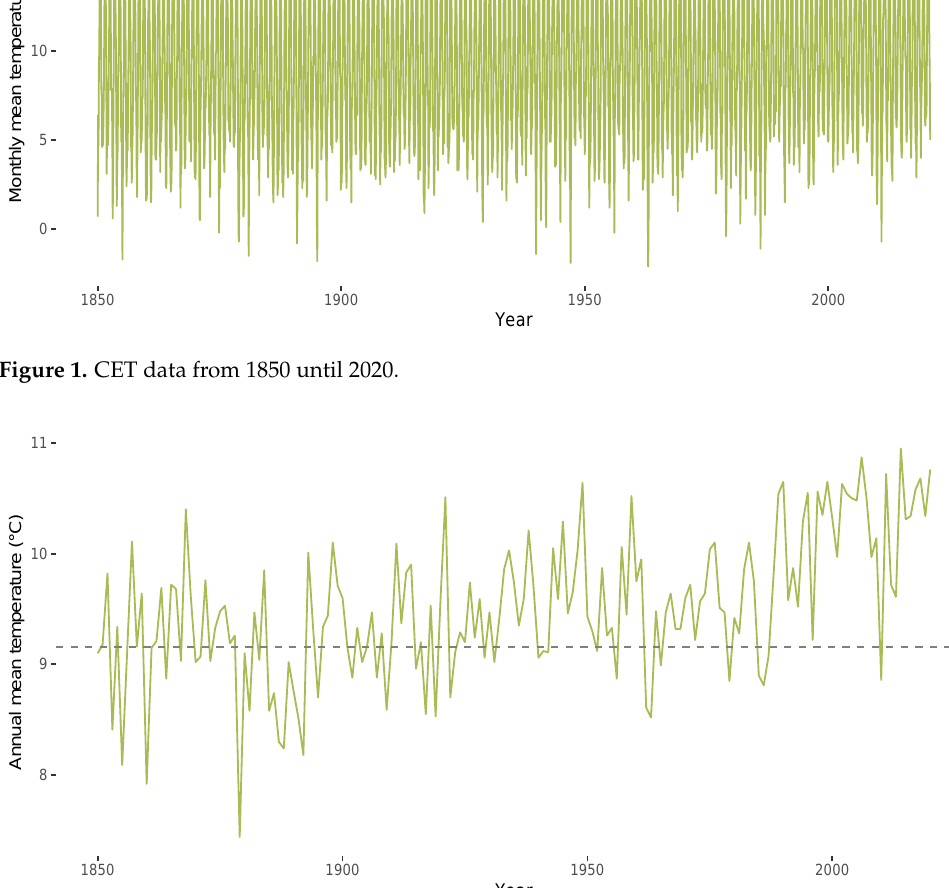
Figure 2. Annual mean temperature in Central England from 1850 until 2020. Dashed grey line represents annual mean temperature during years 1850 until